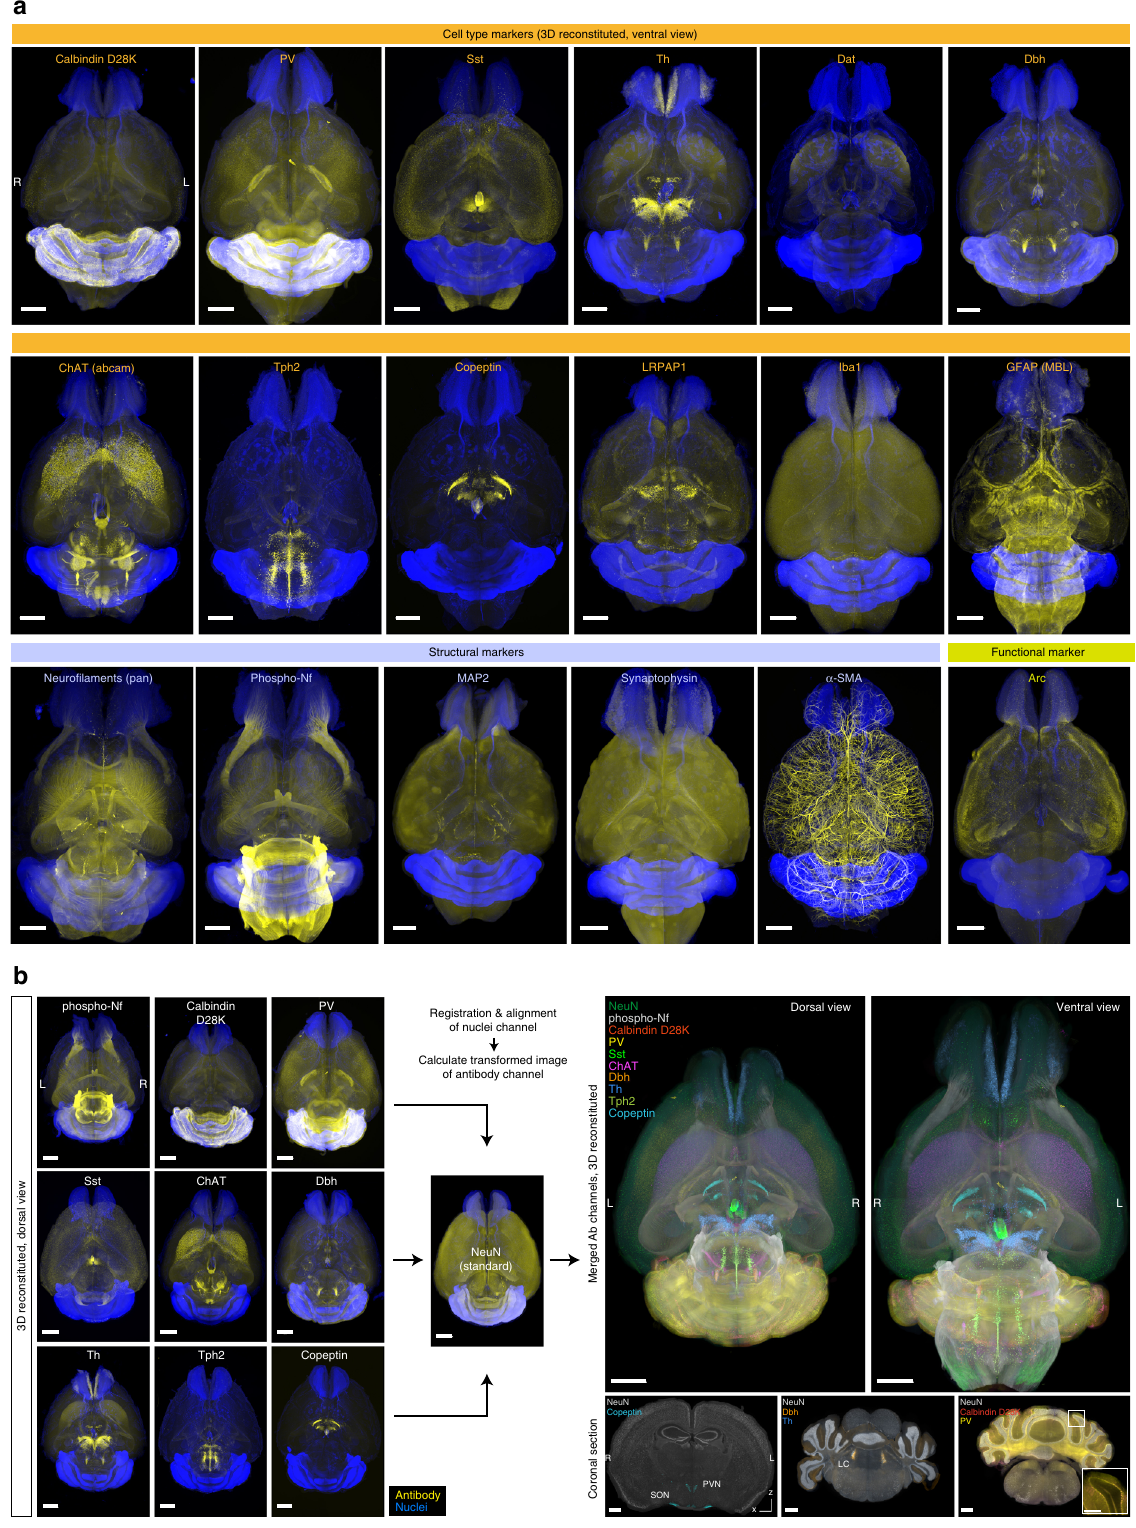
Supplementary Movie 4). We also performed other combinations of multicolor staining and imaging: 4-color staining with